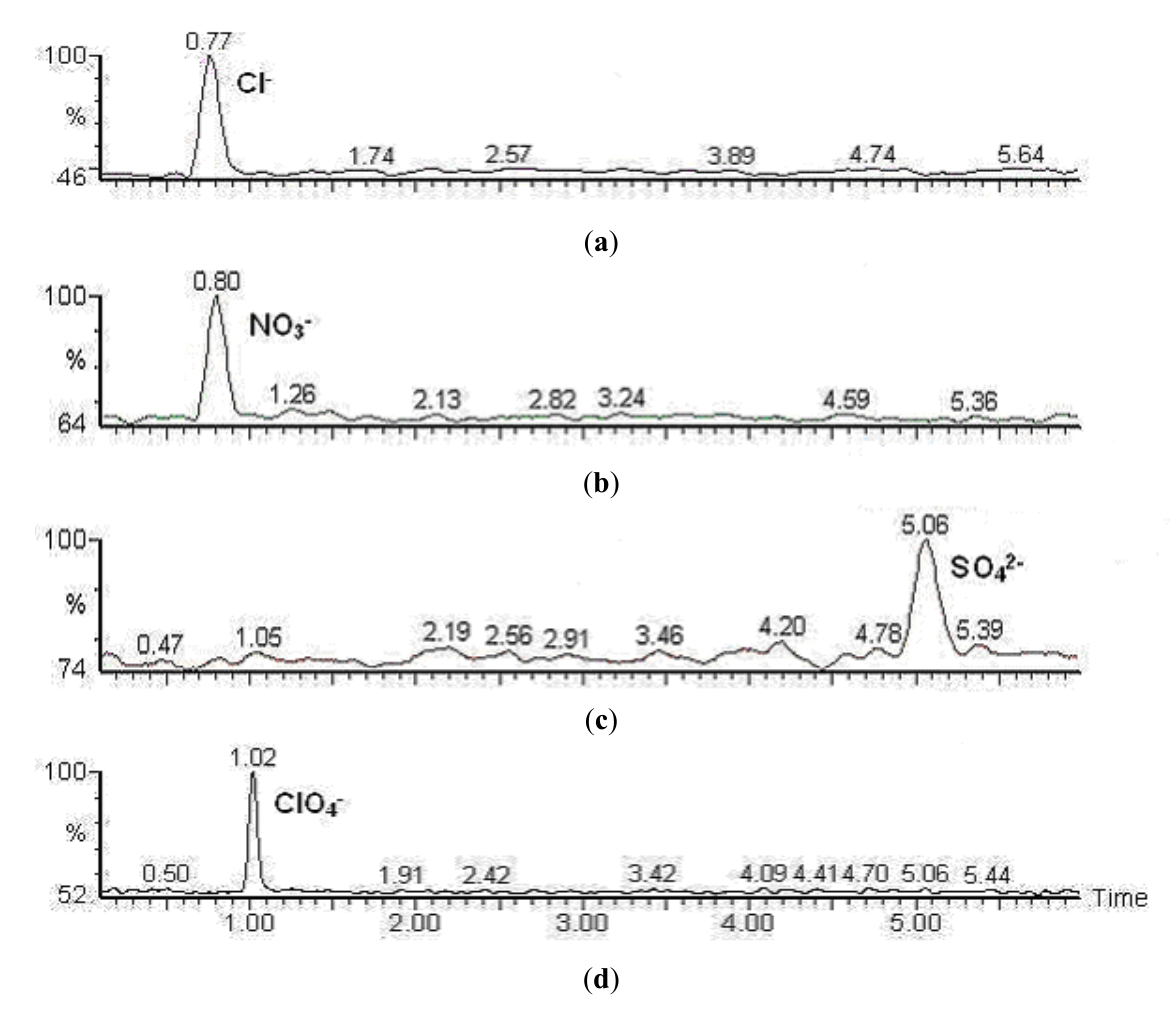
Figure 5. HPLC-ESI-MS/MS of 10 ng/L of perchlorate and 200 mg/L of coexisting common anions. ( a ) MRM for Cl − : m / z 35 to 35; ( b ) MRM for NO ( c ) MRM for SO 42 − : m / z 97 to 97; ( d ) MRM for ClO